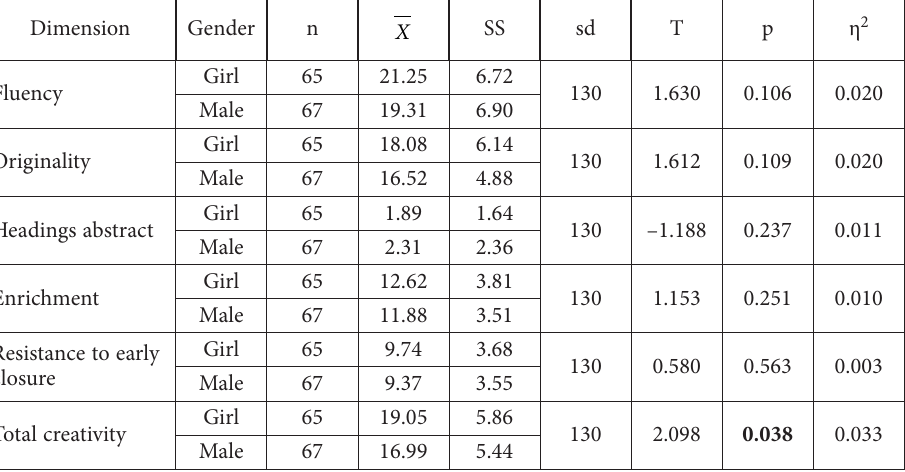
Table 6. Results of T-Test of creativity score of sixth grade children according to gender (source: cre- ated by author) Dimension